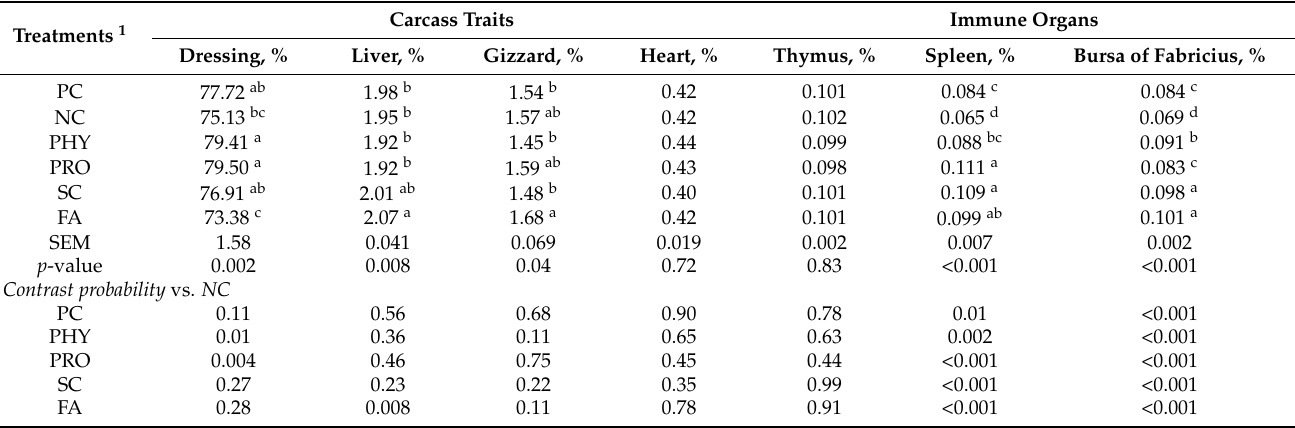
Table 4. Carcass yield and relative organ weights of broiler chickens fed a reduced nPP diet supple- mented with phytase, probiotic, Saccharomyces cerevisiae , and fumaric acid at 35 days of age.